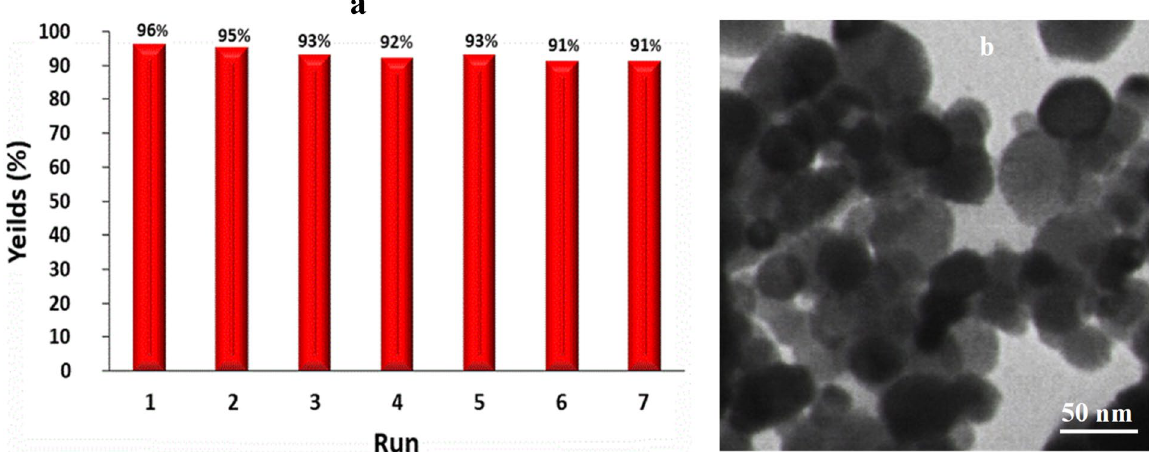
Figure 8. ( a ) Reusability and ( b ) TEM image of recovered algal NiO nanocatalyst in the synthesis of 5 g in